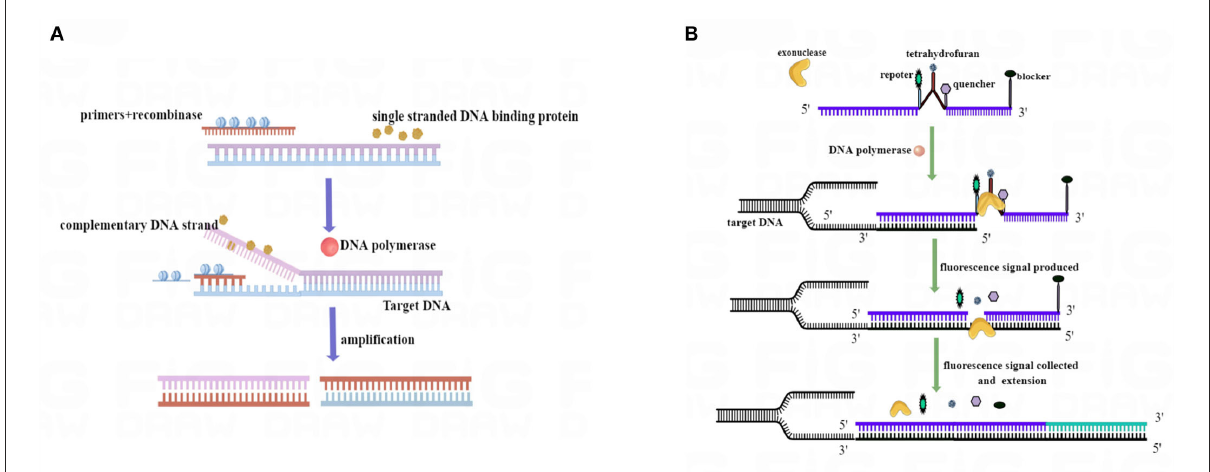
FIGURE1 RAA process schematic diagram. (A) Mechanism based on the RAA process. (B) Mechanism of the real-time RAA probe amplification process. Exonuclease was activated when the probe and template DNA strands were bound. Exonuclease recognized tetrahydrofuran (THF) and cut at the site, separating reporter from quenched groups and generating a fluorescence signal to be collected. After the blocker separation, the probe was further extended in the template to complete the amplification. We drew this schematic diagram by Figdraw (www.figdraw.com).